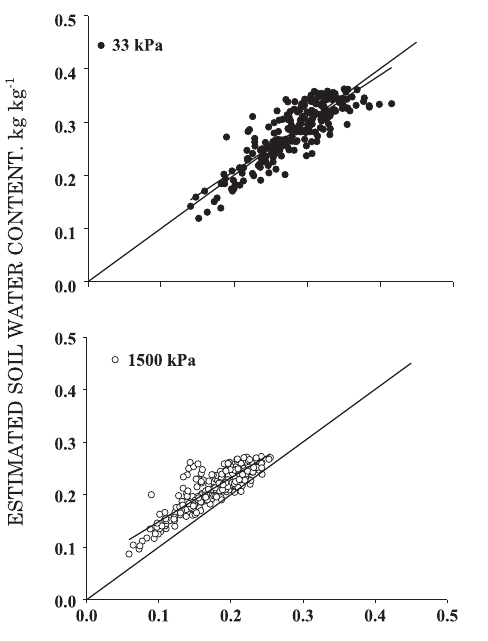
Figure 5. Ratio between the gravimetric soil water content measured for the soils of the irrigation system ( θθθθθ gmI) and that estimated by the proposed model ( θθθθθ ges) for soils with particle size distribution